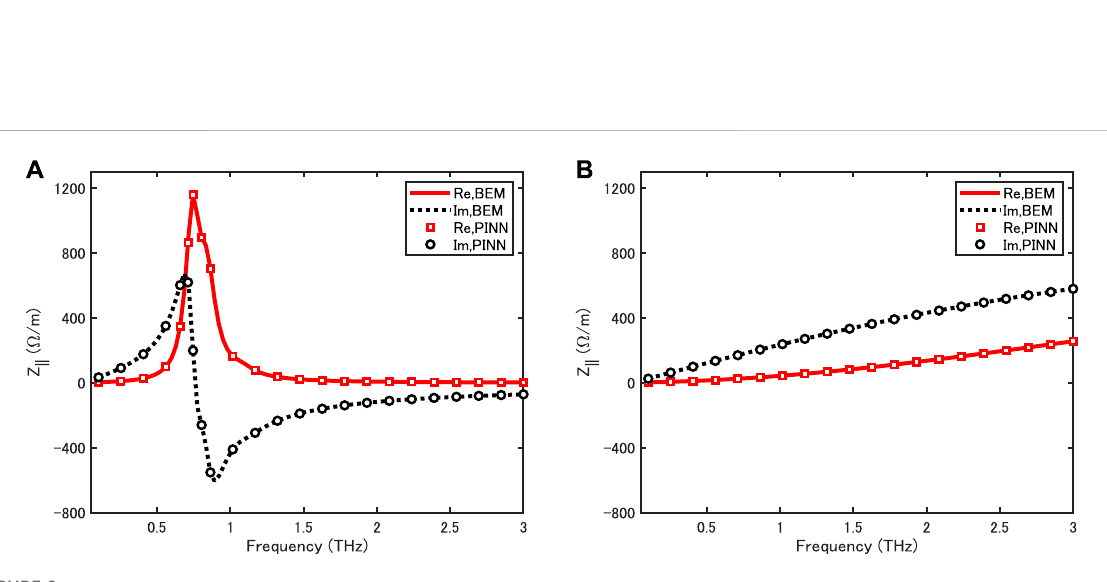
Figure 5 shows the coupling impedances of a round Gaussian beam with σ x = σ y = σ r = 0.5 mm on the axis of the circular chamber for copper (Cu), stainless steel (SS) and